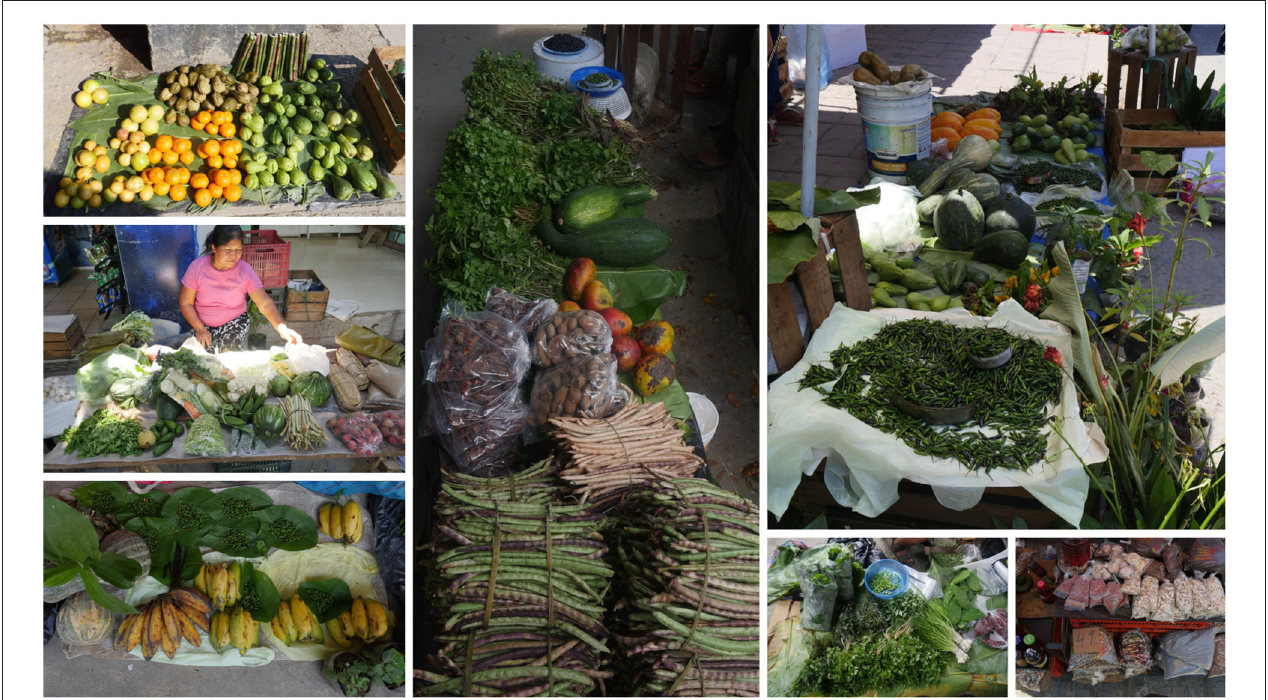
FIGURE 2 | Examples of stands with products offered by local merchants in the rural markets of the Huasteca Potosina.